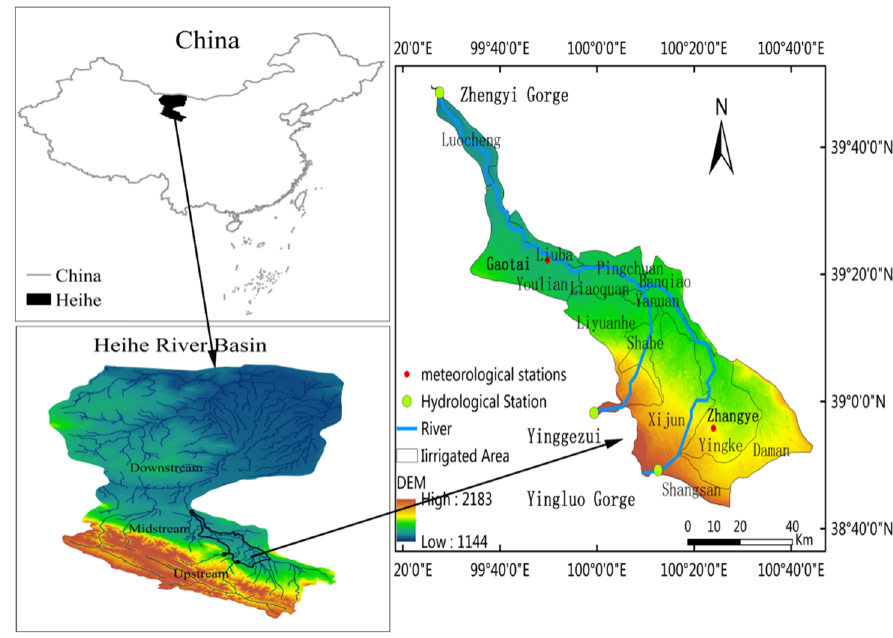
Figure 1. Study area.